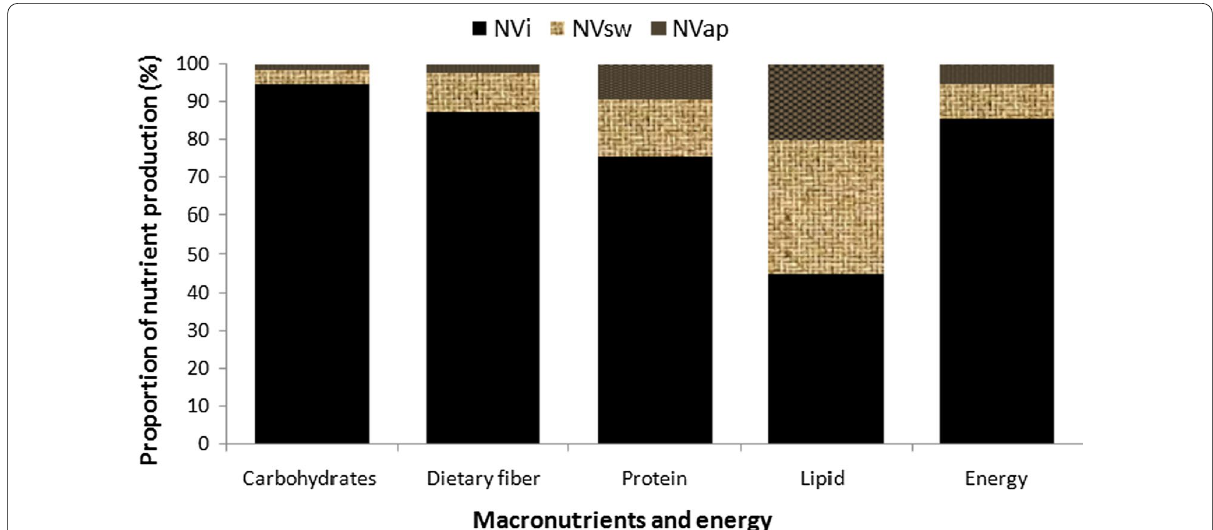
Fig. 1 Proportion of macronutrients and energy attributed to pollinator-independent crops, self- or wind pollination and animal pollination